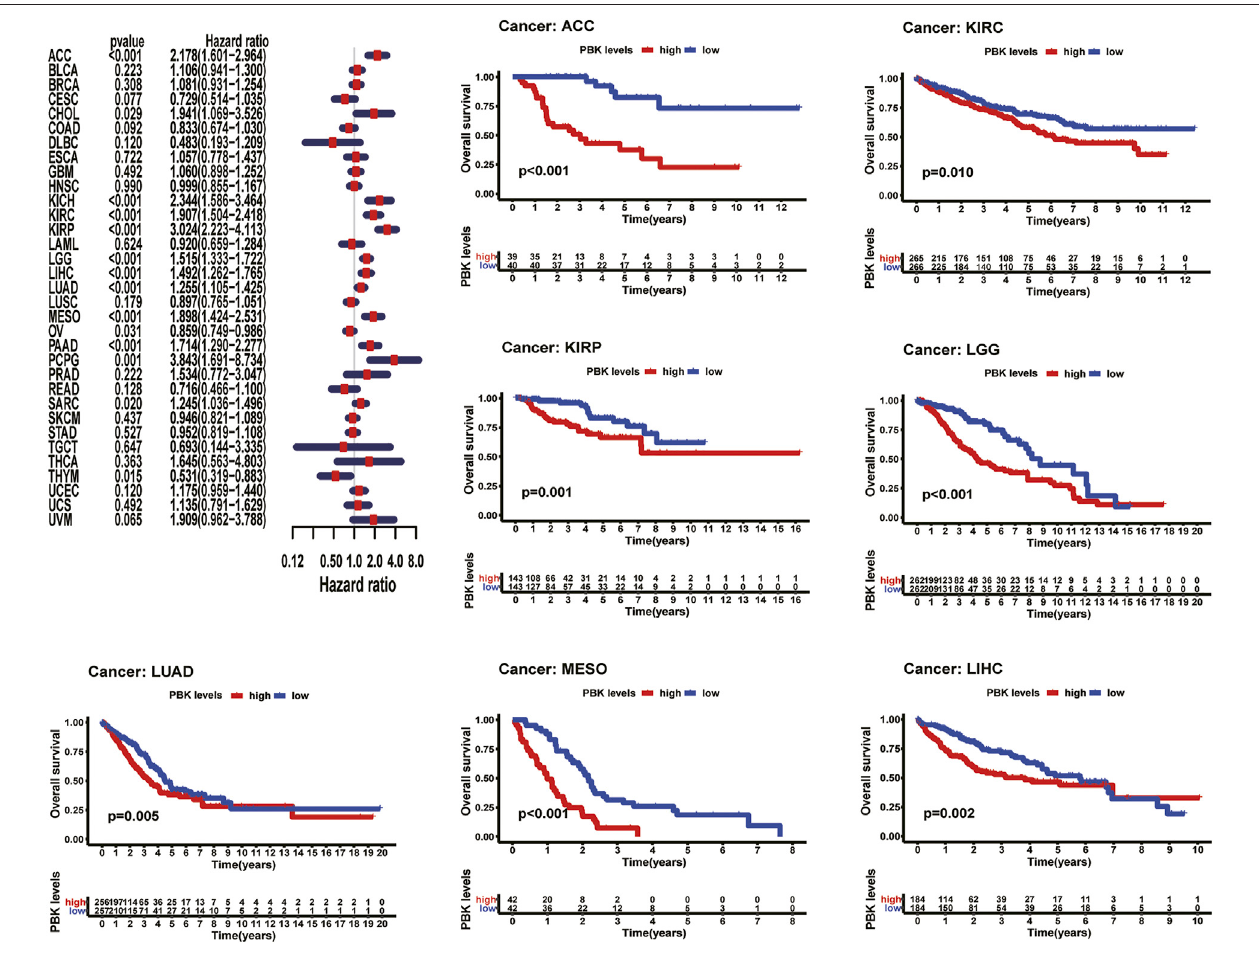
FIGURE 3 | | Relationship of PBK expression with patients ’ DSS. Forest plots of hazard ratios of PBK in 33 cancer types. Kaplan – Meier PFI curves for patients strati fi ed by different expression levels of PBK in seven cancer types.